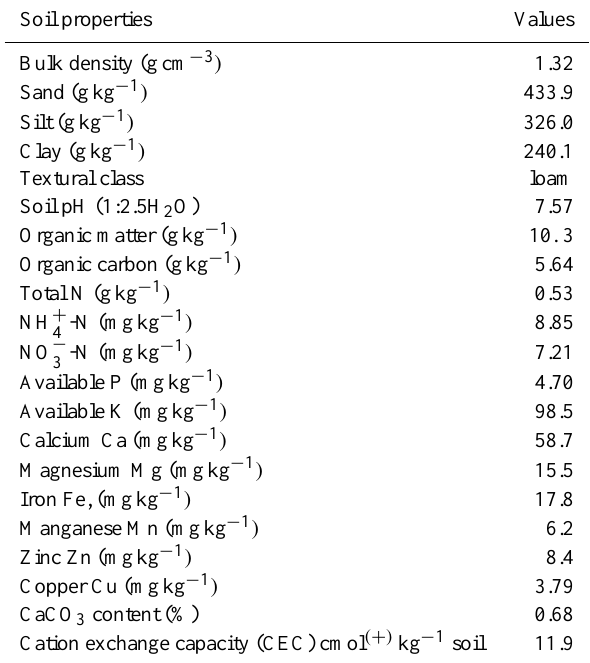
Table 1. The initial physical and chemical characteristics of soil used in the